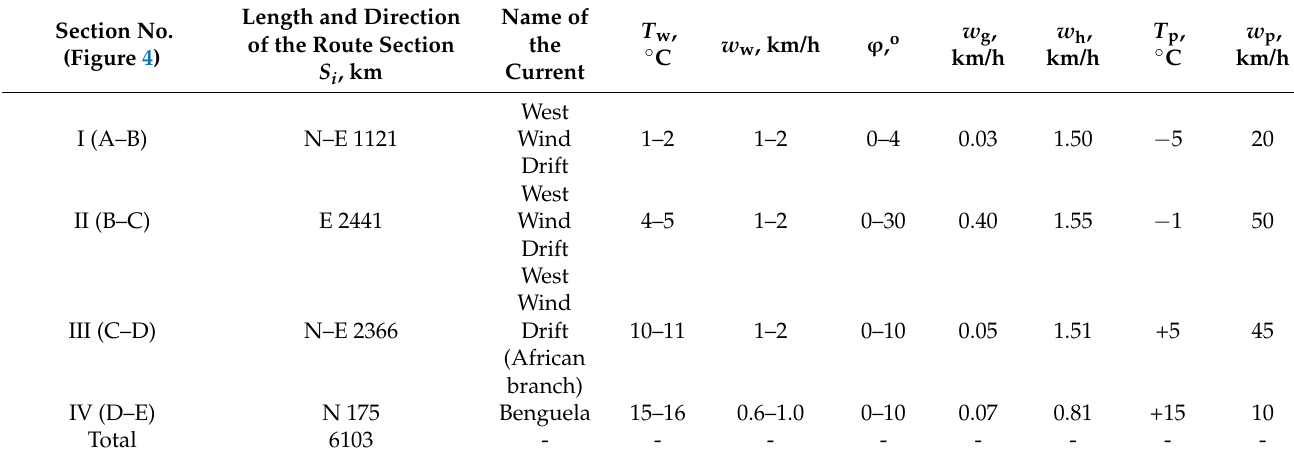
Table 3. Assumptions for input parameters, divided into route sections considering climate zones (own elaboration). Section No.